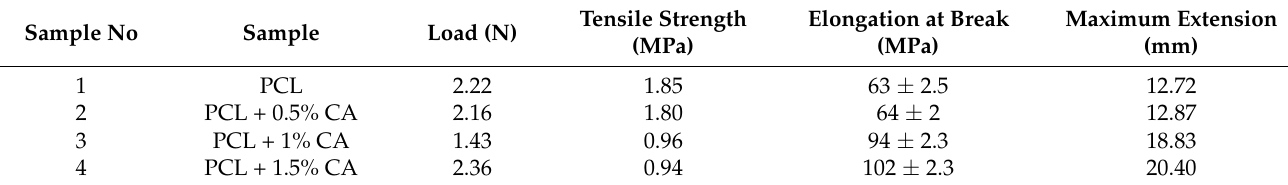
Table 3. Tensile strength profiles of c-spun PCL and PCL-CA fibrous